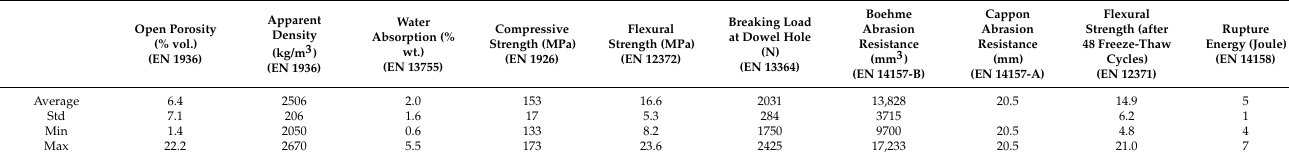
Table 6. Average values of physical mechanical properties determined for sandstones.